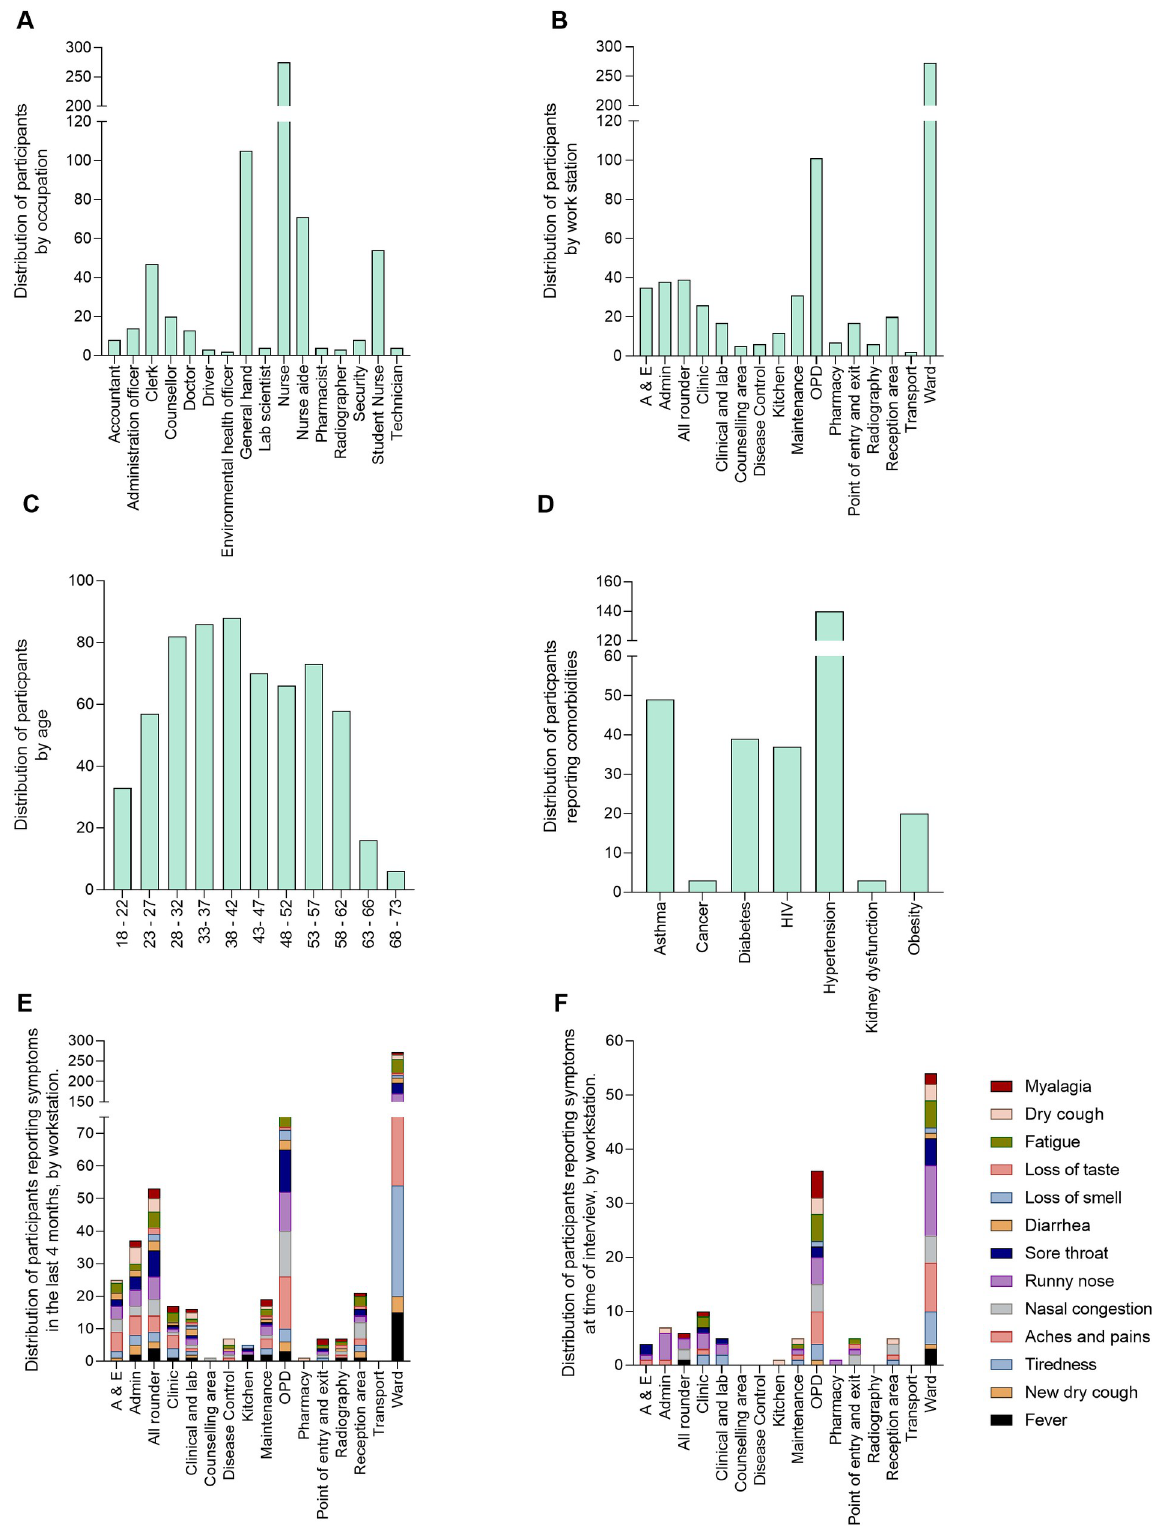
Fig 3. Study population represented as %. A) Partitioned by occupation. B) Partitioned by workstation. C) Partitioned by age group. D) Partitioned by self-reported co-morbidities. E) Partitioned by self-reported COVID-19-like symptoms and work station within the previous 4 months. F) Partitioned by self-reported COVID-19-like symptoms and work station at time or enrolment into the study.